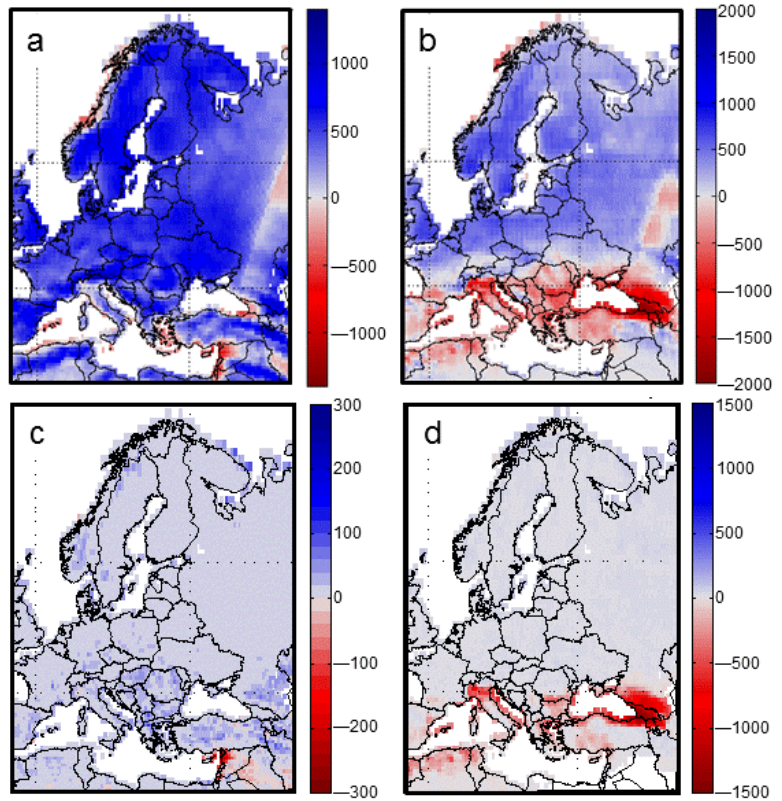
Figure 5. Example of precipitation frequency bias (expressed as number of days in a 30-year period) in one climate projection as compared with WFDEI during winter ( a ) and summer ( b ). Remaining bias after application of the DBS method in winter ( c ) and summer ( d ).